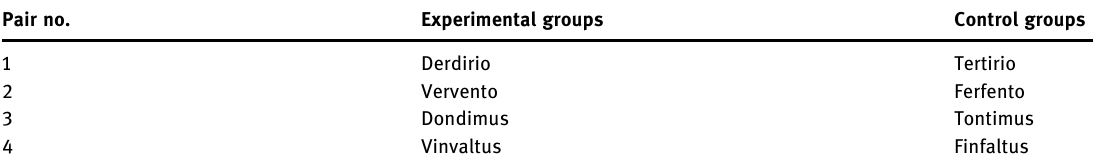
Table 7: Stimuli in the “ Vcd Obs ” condition Pair